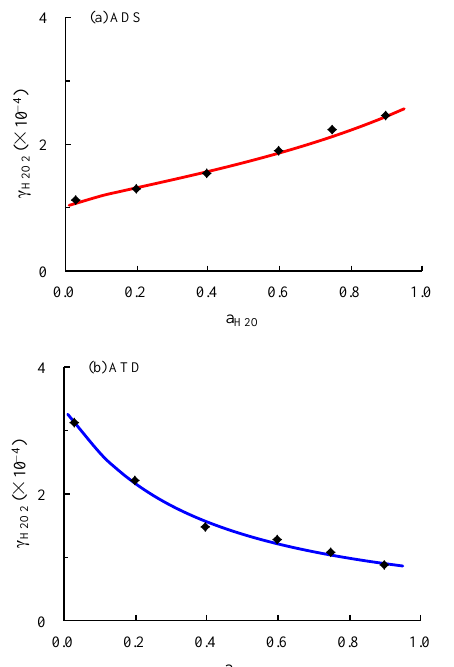
Figure 7. Uptake coefficient of H 2 O 2 on ADS and ATD particles. The red line and the blue line in (a) and (b) represent the empirical fit of γ H on ADS and ATD particles, respectively. 2 O 2